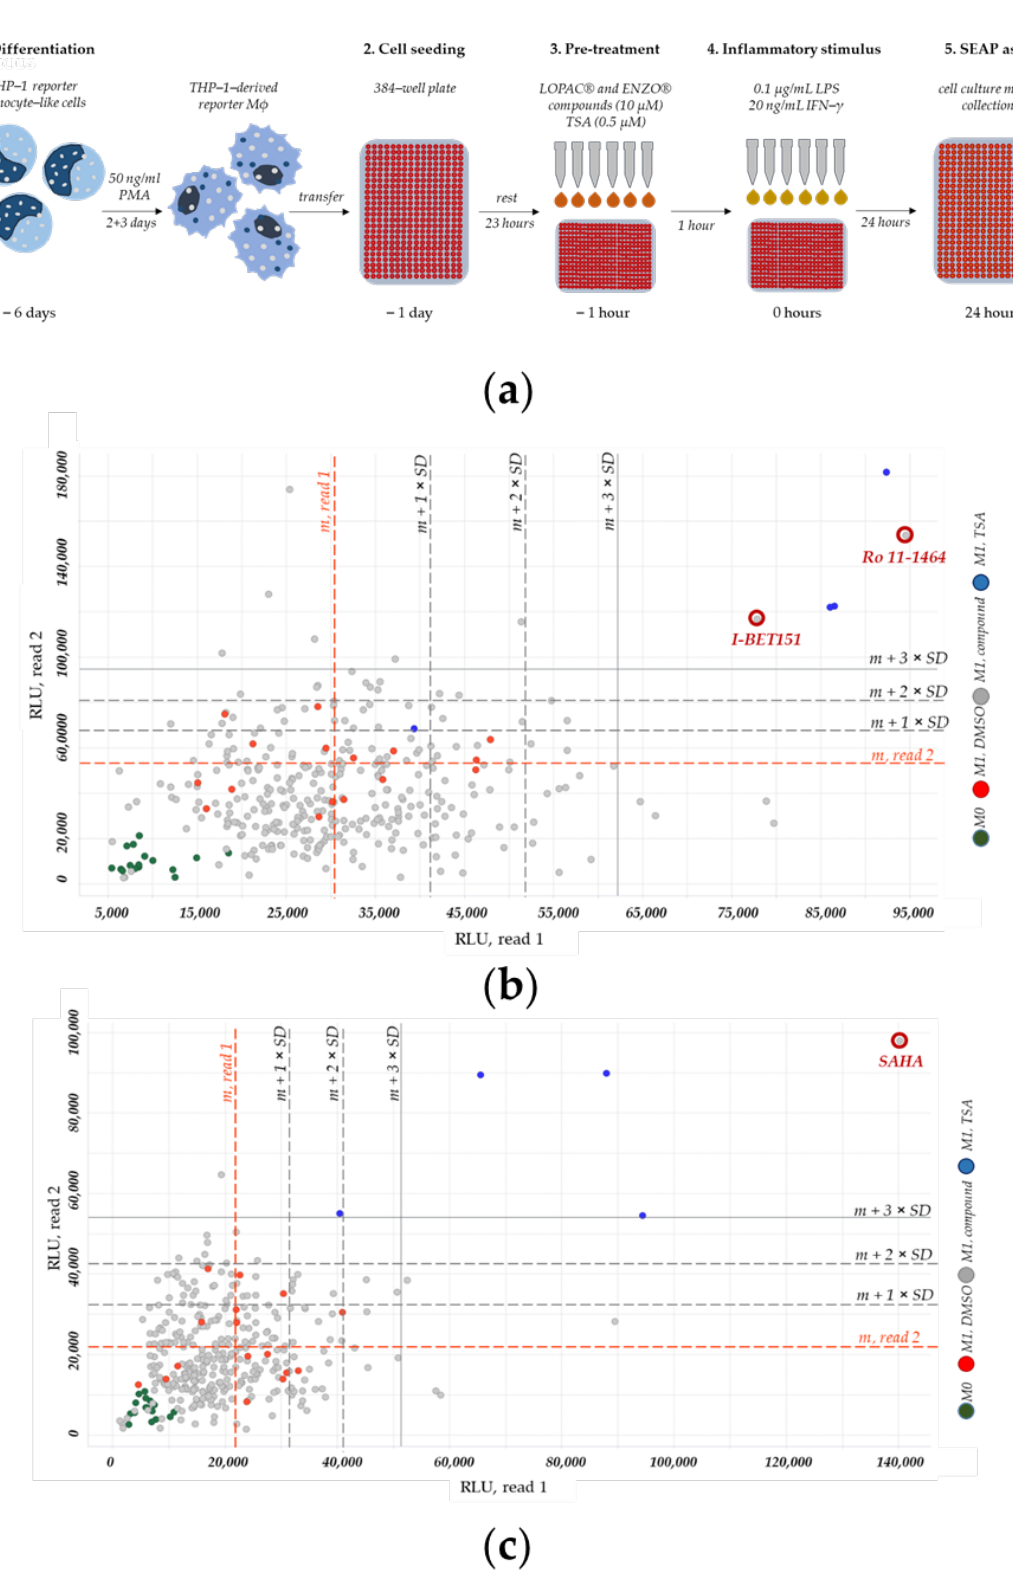
Figure 3. HTS for CEBPD -modulating compounds and identification of hits. ( a ) A schematic drawing of the developed screening assay in THP-1 reporter M φ using SEAP reporter. ( b , c ) Here, we show the hit-contained screening plate from the LOPAC ® ( b ) and the hit-containing screening plate from the ENZO ® ( c ) compound libraries. The primary screening data from all plates is summarized in supplementary Tables S1 and S2. PMA-differentiated THP-1 reporter M φ were not treated (M0), pre-treated with 0.001% ( v / v ) DMSO (solvent control), 10 µ M compound from LOPAC ® (b) and ENZO ® (c)